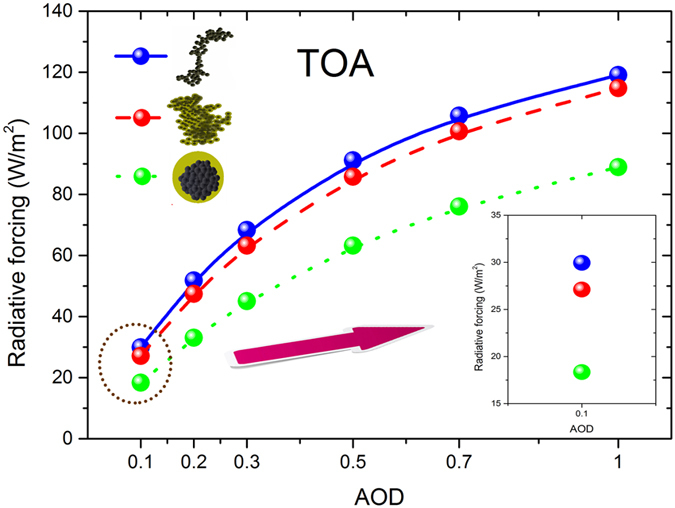
Similar as Fig. 5, but at TOA.